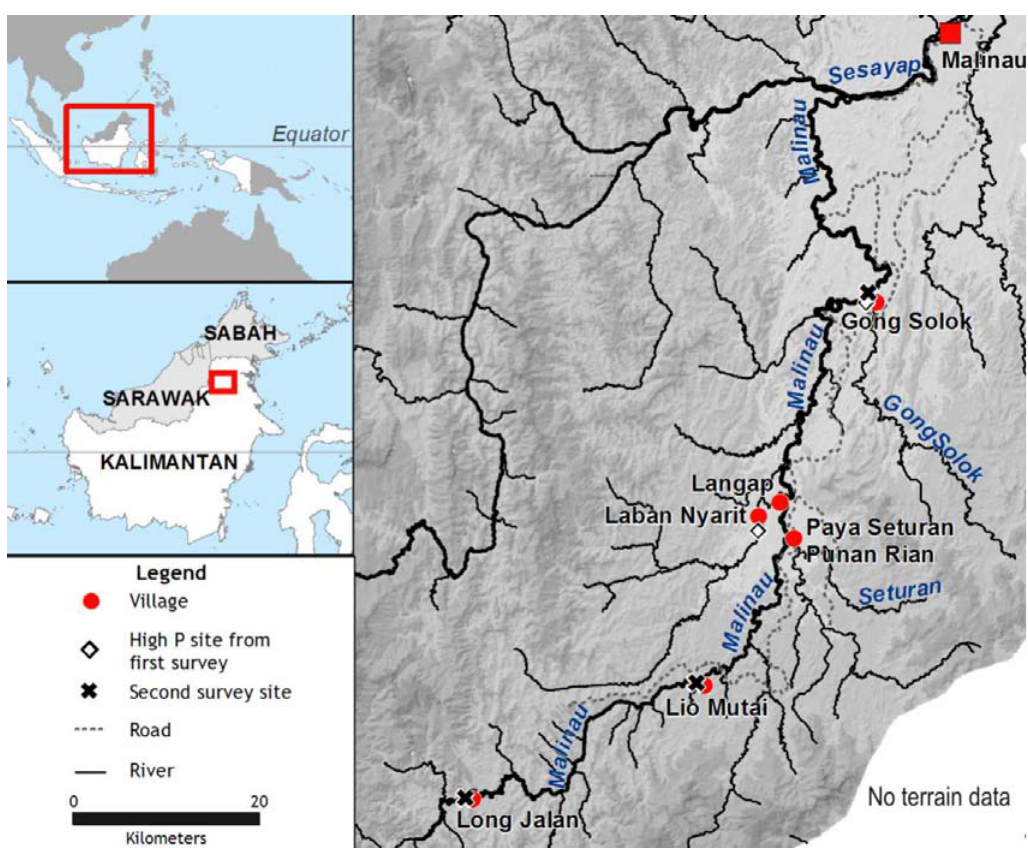
Figure 4. Location of Borneo (top left) and study region in Borneo (mid-left) and the study area with the six focal villages and soil locations (main